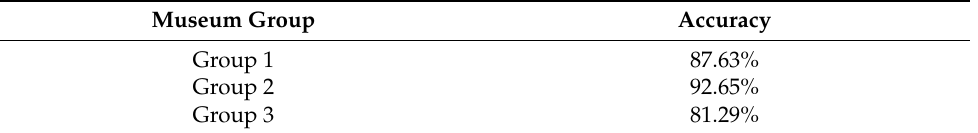
Table 1. Accuracy results for Tweet GOOD/BAD classification for the three museum groups.